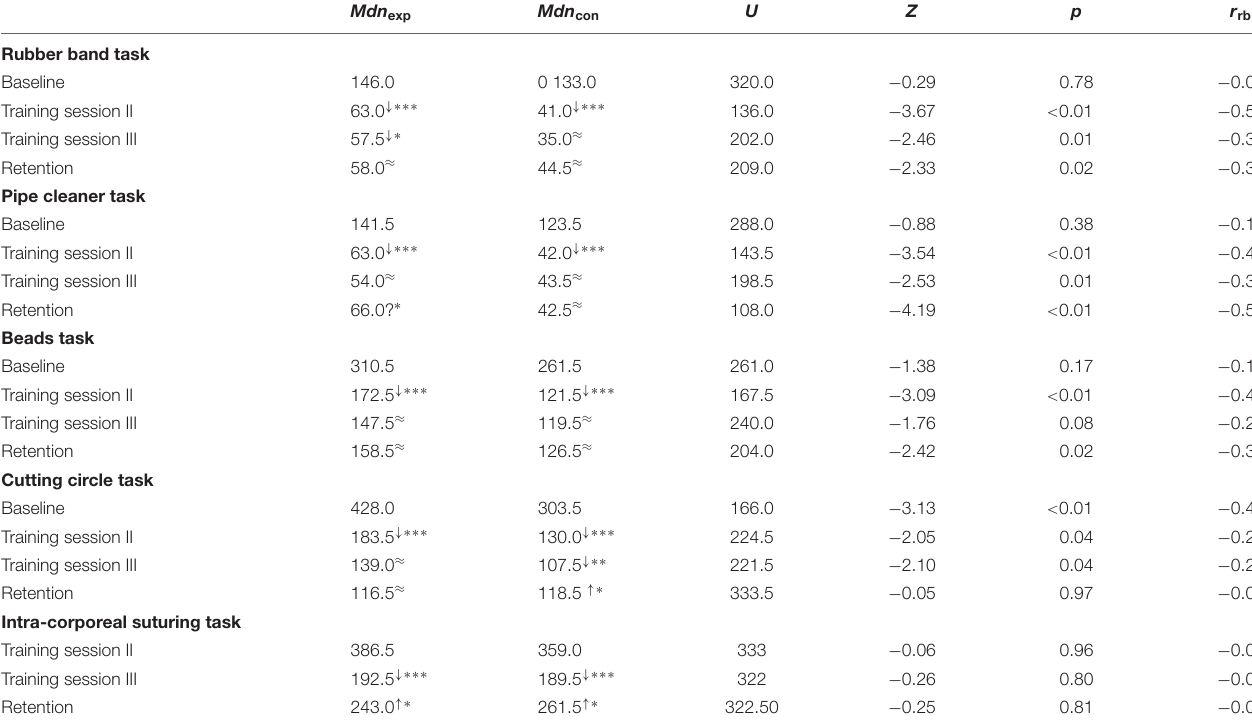
TABLE 3 | Results of the Mann–Whitney tests with median completion times (in seconds) and effect sizes ( r rb ) for the five training tasks